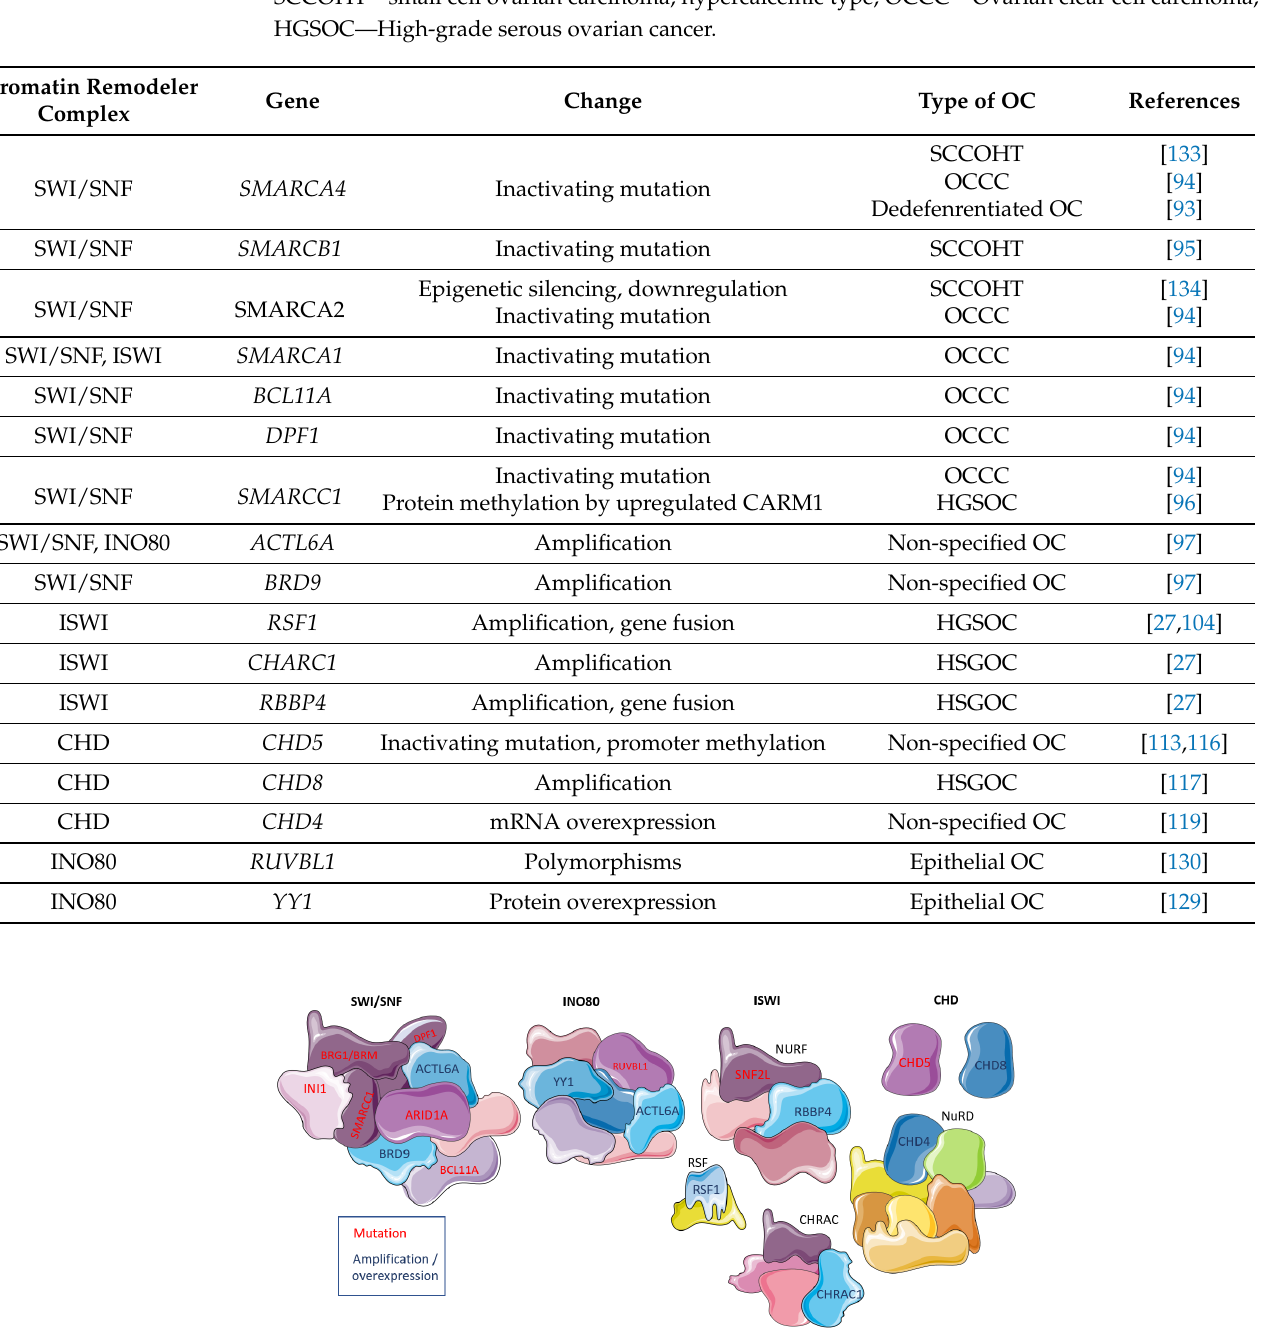
Table 4. Overview of CRC alterations other than ARID1A in ovarian cancer. OC—ovarian cancer,